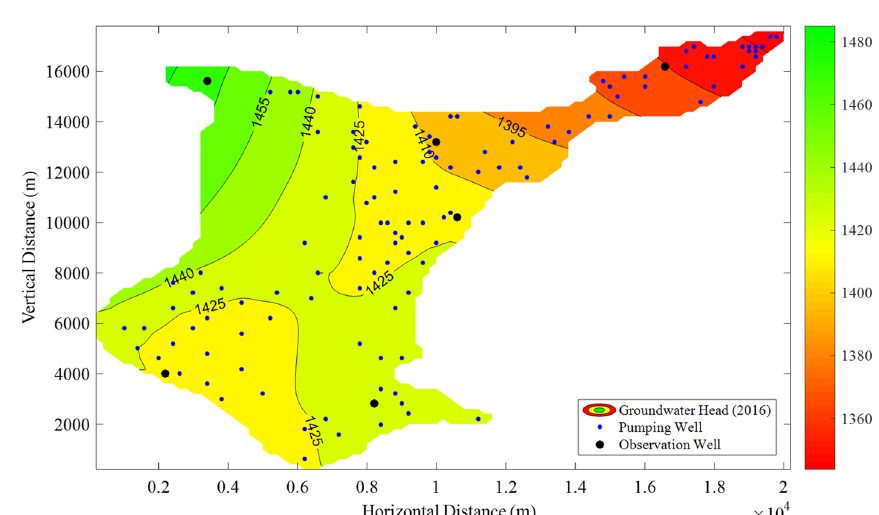
Fig. 10 Groundwater head contour lines from the model